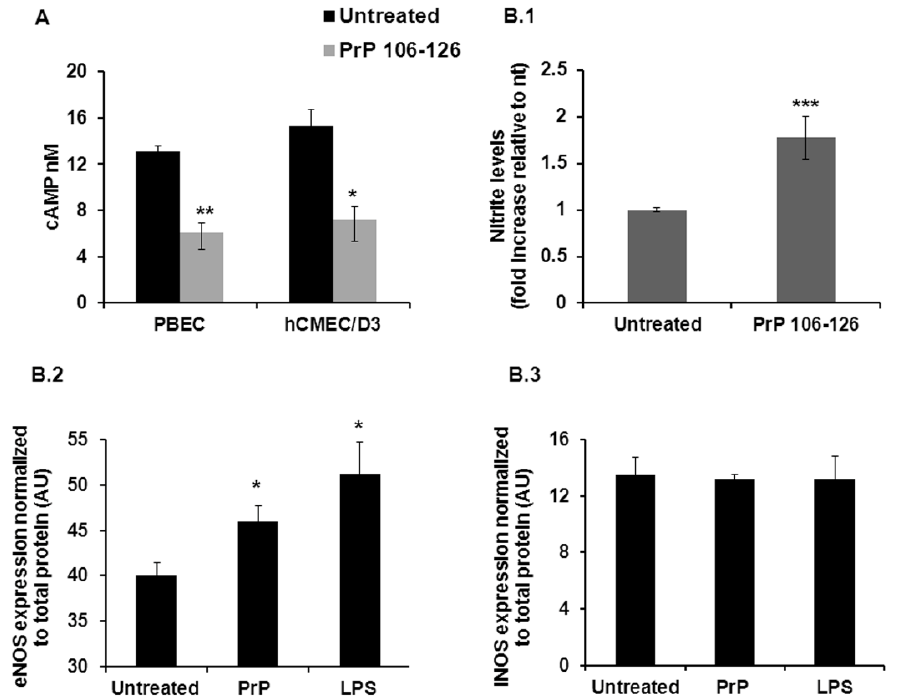
Figure 2. cAMP, NO and NOS levels in PBEC after PrP 106-126 treatment. ( A ) cAMP levels decreased by more than 50% after 2 h treatment with PrP 106-126 in both PBEC and human brain endothelial cell line ( n = 3). Results are expressed as the mean ± SEM. ( B.1–B.3 ) NO levels increased in the cell medium after exposure to PrP 106-126 ( B.1 ); NO levels were measured in the supernatants of PBEC treated with PrP 106-126 or non-treated cells using a Griess colorimetric assay ( n = 14–29). The expression level of eNOS ( B.2 ) but not of iNOS ( B.3 ) was elevated after exposure to PrP 106-126 (2 h treatment, expression levels were measured using in-cell western blot (protocol is described in Section 4), n = 3–4. LPS served as positive control [37]. * p < 0.05, ** p < 0.01, *** p < 0.001 compared with untreated. nt; not treated, PrP; PrP 106-126.